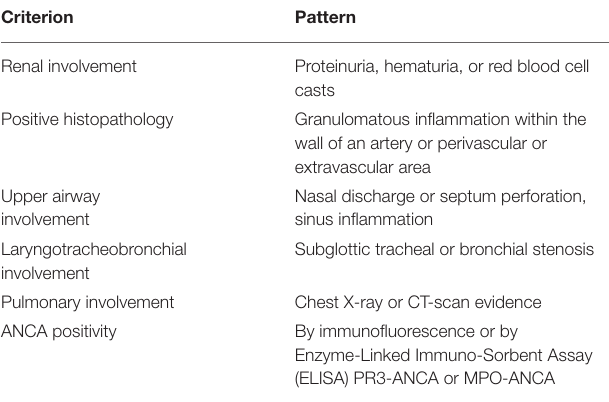
TABLE 7 | Classification criteria of MPA according to the Annals of the Rheumatic Diseases of the BMJ.